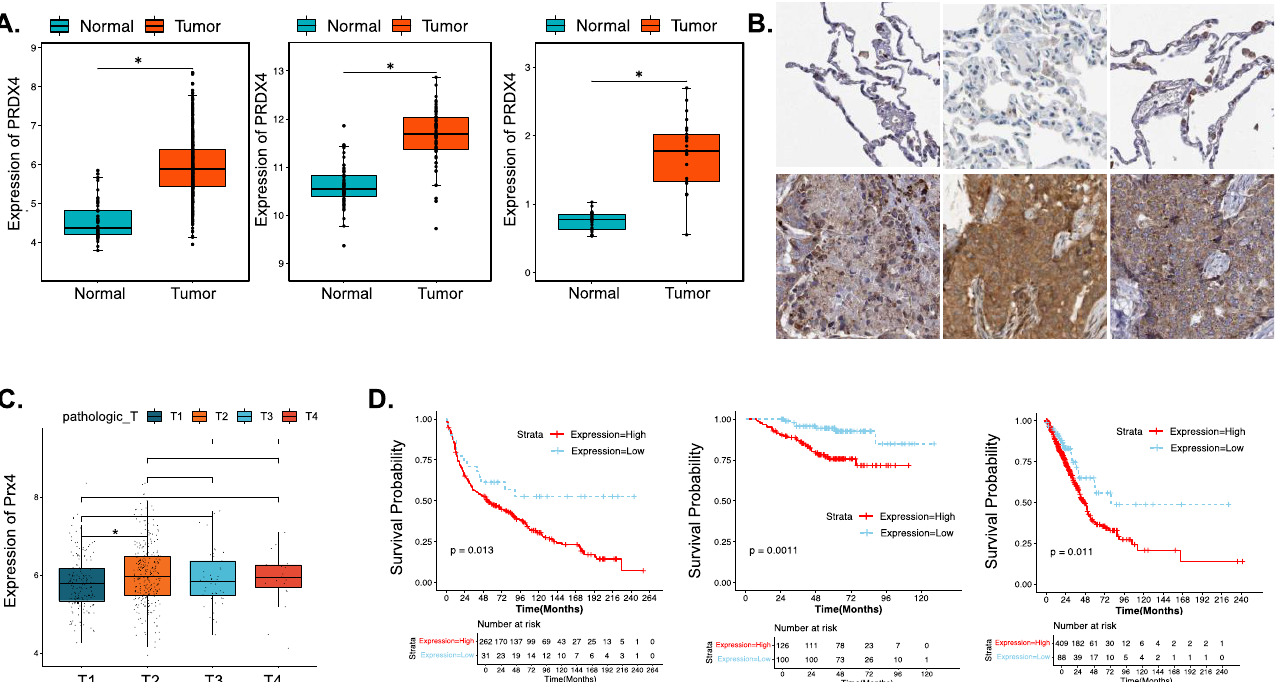
Figure 4. Prx4 is upregulated in lung adenocarcinoma, and negatively related to prognosis. ( A ) The expression level of PRDX4 in LUAD and normal tissues from TCGA-LUAD, GSE19804, and GSE27262 datasets. ( B ) Example results of anti-Prx4 staining of normal (upper) and tumor (lower) tissue from six patient samples obtained from Human Protein Atlas. ( C )The expression level of Prx4 in different stages of LUAD. ( D ) Impact of PRDX4 expression on overall survival in LUAD patients. (*, p < 0.05). Table 1. Clinical characteristics of LUAD patients between high- and low-expression groups of PRDX4.